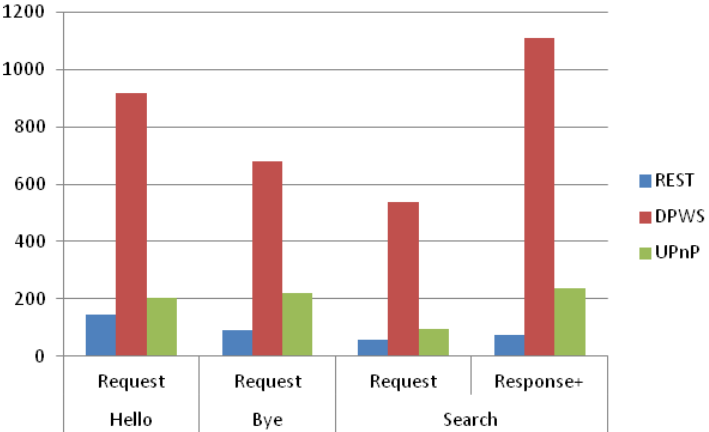
Figure 10. Comparison of message size (bytes) for discovery use